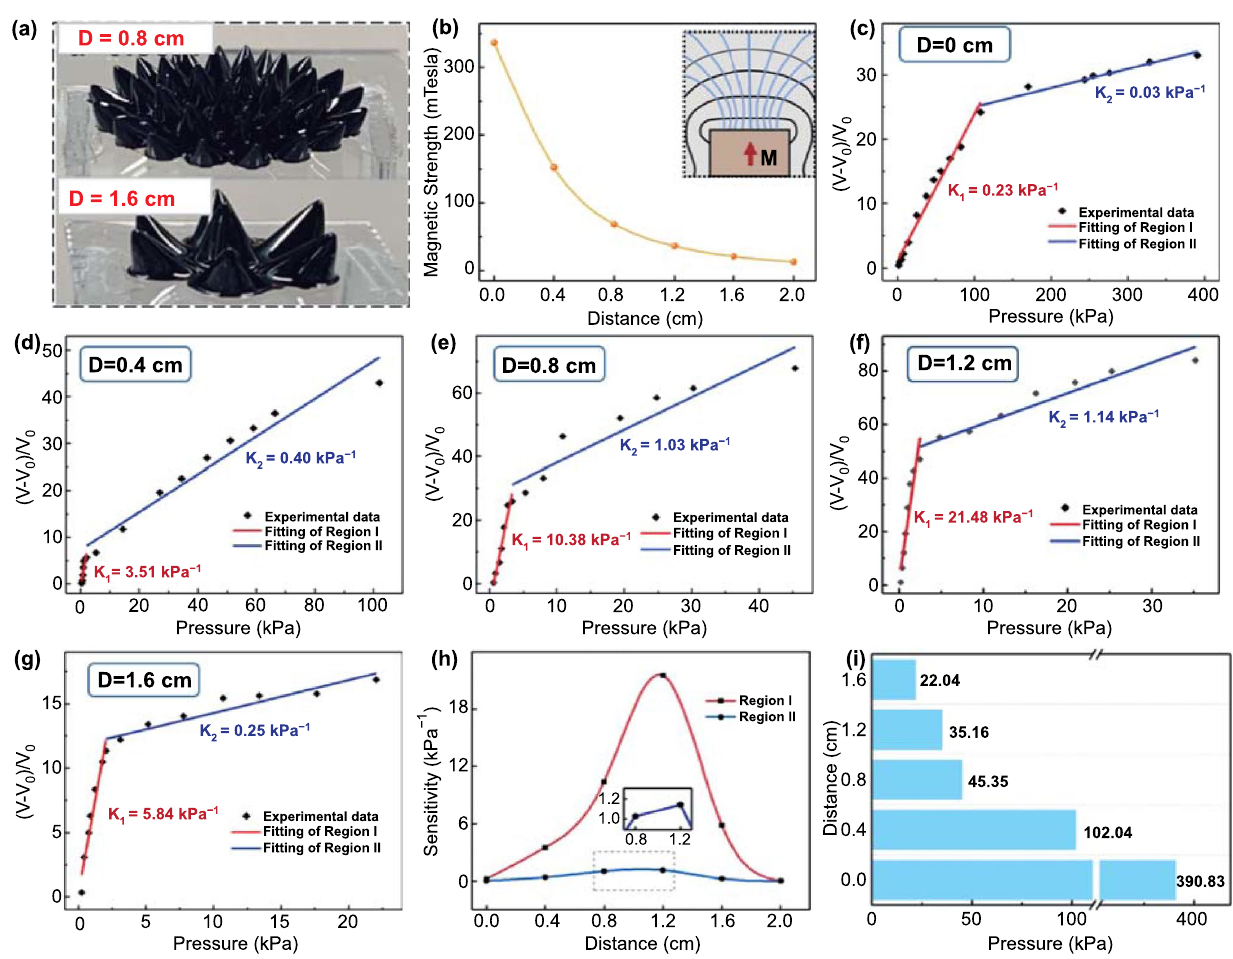
Fig. 3 Pressure sensing performance under different distances ( D ) with magnet. a Photograph of diverse formations of ferrofluid at different distances. b Characterization of the magnetic field strength generated under different distances. The inset shows the magnetic induction line in the direction of distance change. c‑g The summarized relationship and linear fitting between the relative variations of voltage and the pressure applied on the device under different distances with magnet, from 0 to 16 mm at 4 mm intervals. The summarized variation of h sensitivity and i detection range of pressure sensor under different distances with